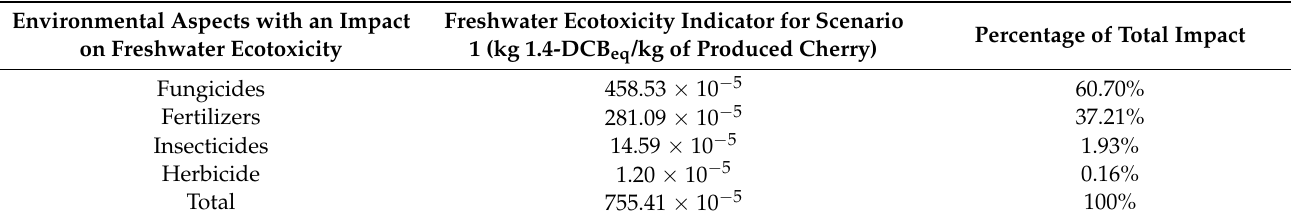
Table 5. The freshwater ecotoxicity Indicator of the various environmental aspects for the FU of 1 kg of produced cherry for the real